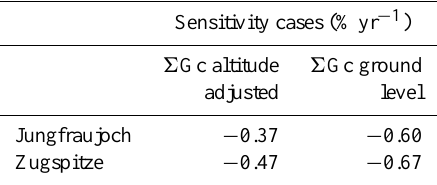
Table 9. Modeled trends at ground level and adjusted